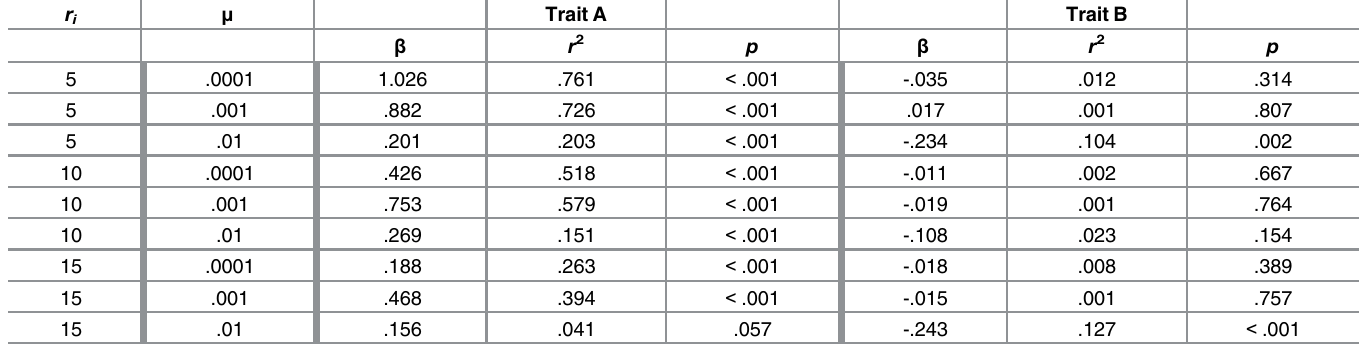
Table 2. Results of regressing t F on r e for d =